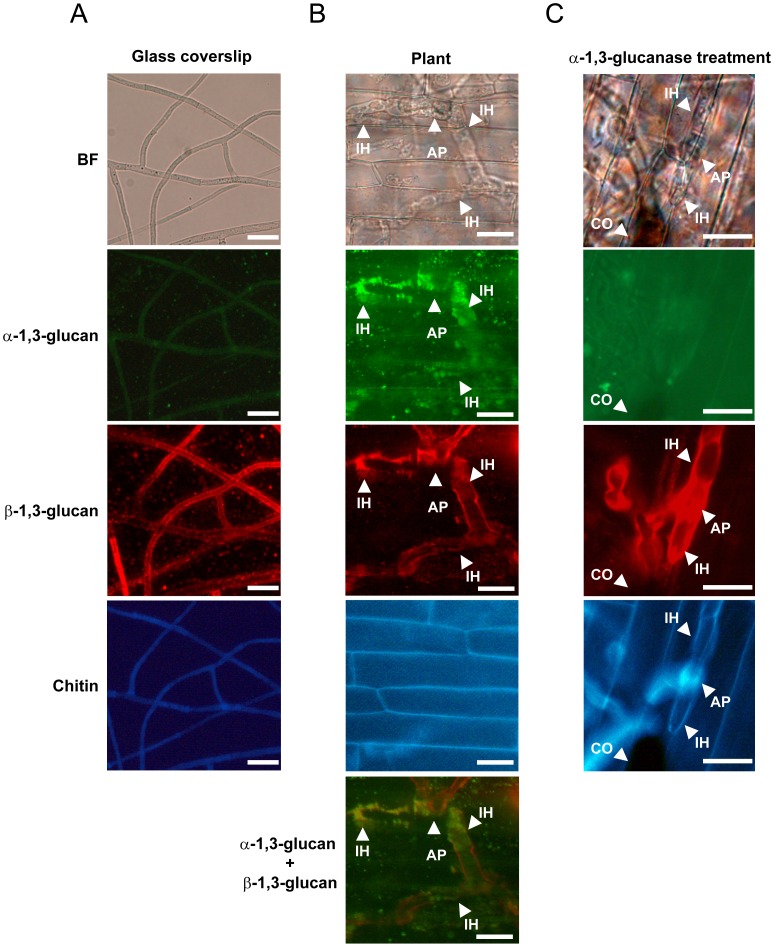
The detection of polysaccharides on the hyphal cell walls of C. miyabeanus.α- and β-1,3-glucan were detected using fluorophore-labeled antibodies, and chitin was detected using a fluorophore-labeled lectin. (A) The detection of polysaccharides at the accessible surface of the cell wall of mycelia developed on glass coverslips. Representative images from more than 100 fungal cells from two independent experiments are presented. (B) The detection of polysaccharides at the accessible surface of the cell wall of infectious hyphae developed on rice sheath cells. Layered images of α- and β-1,3-glucan are presented as ‘α-1,3-glucan+β-1,3-glucan’. Representative images of 50 fungal cells from 10 independent experiments are presented. (C) The detection of polysaccharides in the cell wall of infectious hyphae treated with α-1,3-glucanase. The representative images of 50 fungal cells from 10 independent experiments are presented. BF, bright-field optics; AP, appressorium; IH, infectious hyphae; CO, conidia. Scale bar = 20 µm.